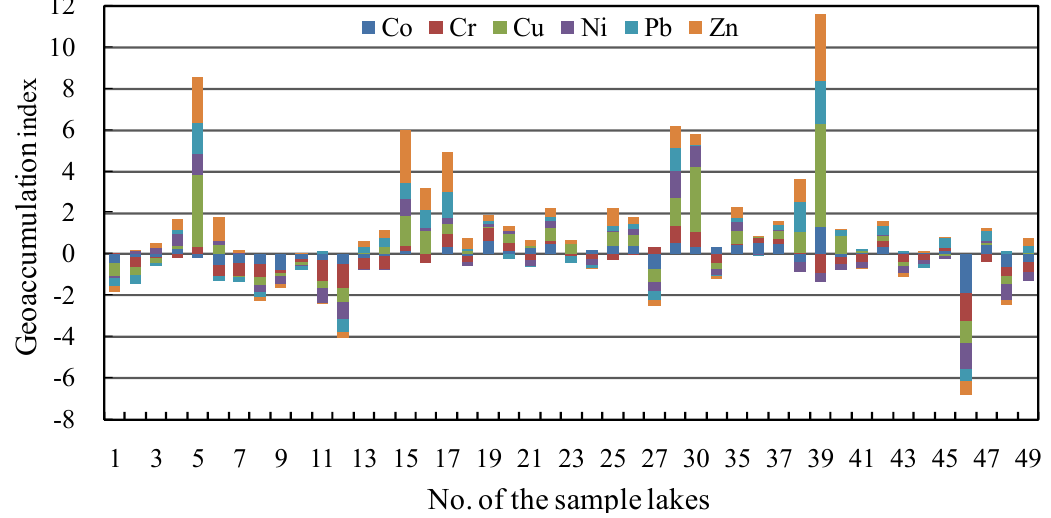
Figure 7. Spatial distribution of I s of heavy metals in lakes along the middle and lower g reaches of Yangtze River. Lakes in the Taihu Delta include No. 1 to No. 16; Lakes in the upper part of the lower Yangtze River include No. 17 to No. 39; Lakes in the middle reach of Yangtze River include No. 40 to No.